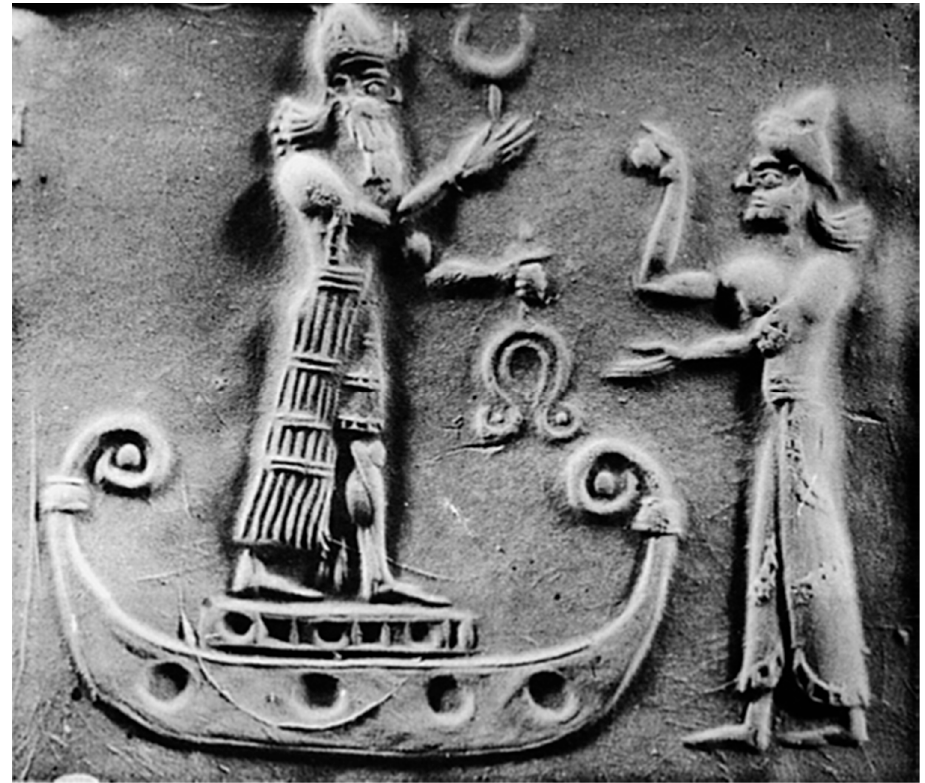
Figure 19. Seal from Samsat: Moon god in a boat, holding crescent and omega signs (Özgüç 1987, p. 436, no.